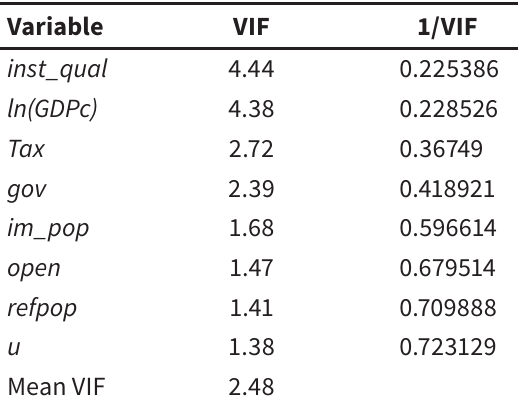
VIF test results for multi-collinearity detection